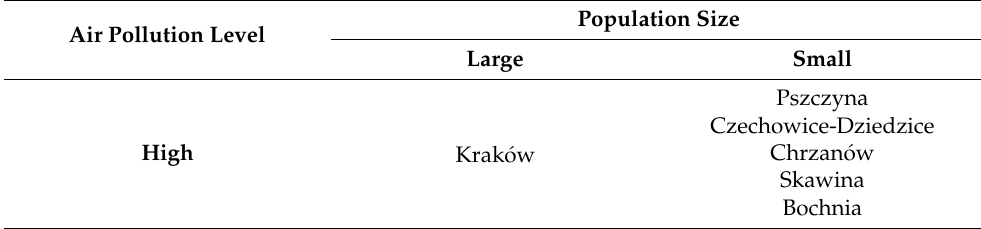
Figure 1. NeuroSmog study towns coloured according to their population-weighted median PM 2.5 (2015) levels, as well as the locations of the air-monitoring stations used for air pollution modelling (blue dots), and location of Poland on the map of Europe (study area highlighted by a black square). Table 1. NeuroSmog study towns by